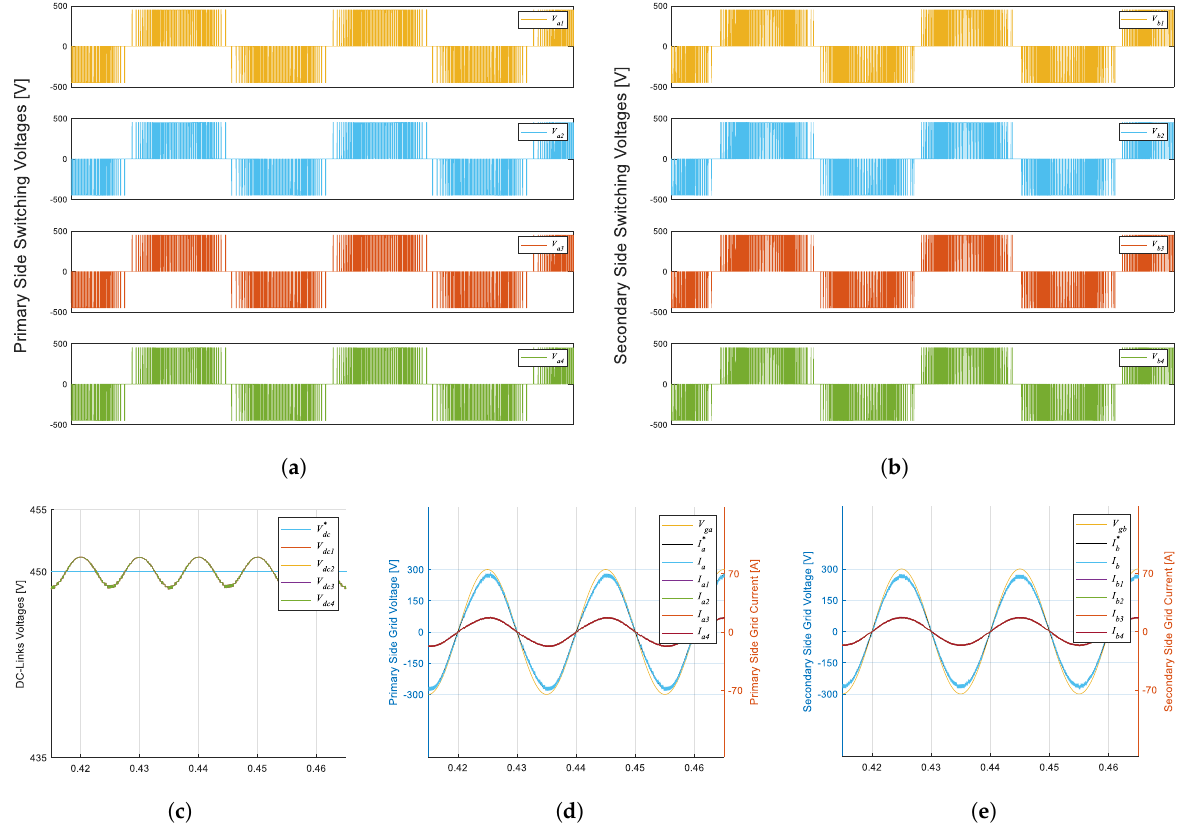
Figure 16. The 4-modules IPOP configuration simulation results: ( a ) primary side switching voltages, ( b ) secondary side switching voltages, ( c ) DC-links voltages, ( d ) primary side grid voltage and currents, ( e ) secondary side grid voltage and